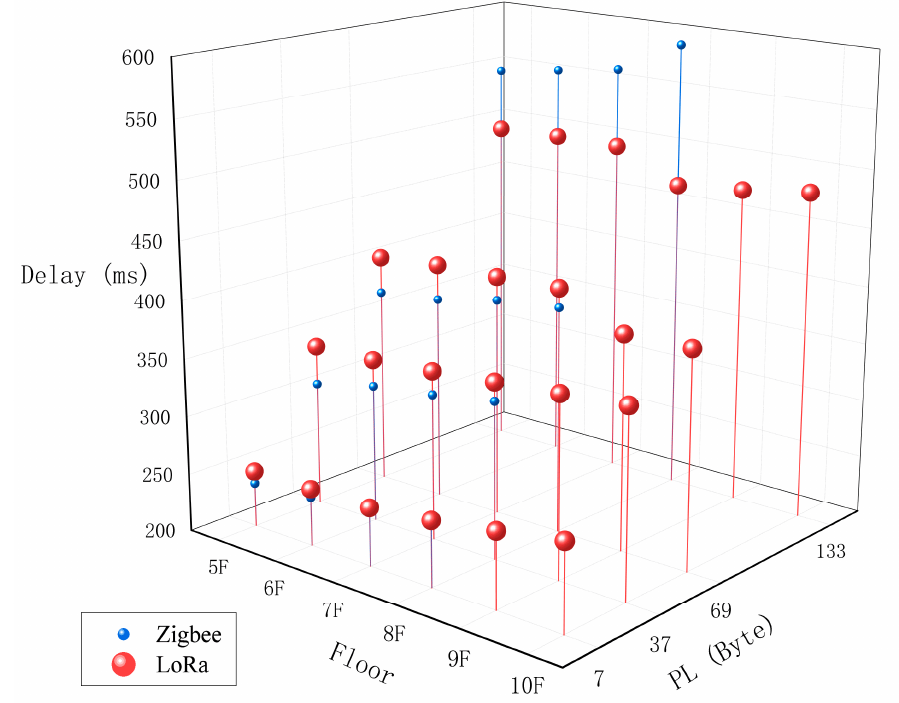
Figure 12. Test results of RTT in central position.